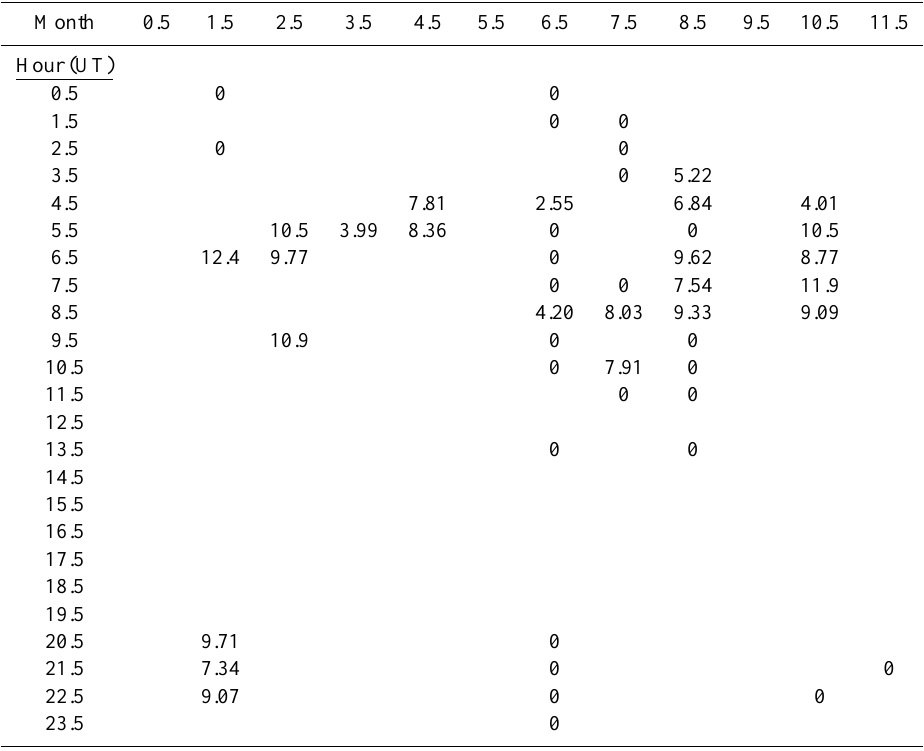
Table A5. Median Electron density at 80km for 1dB